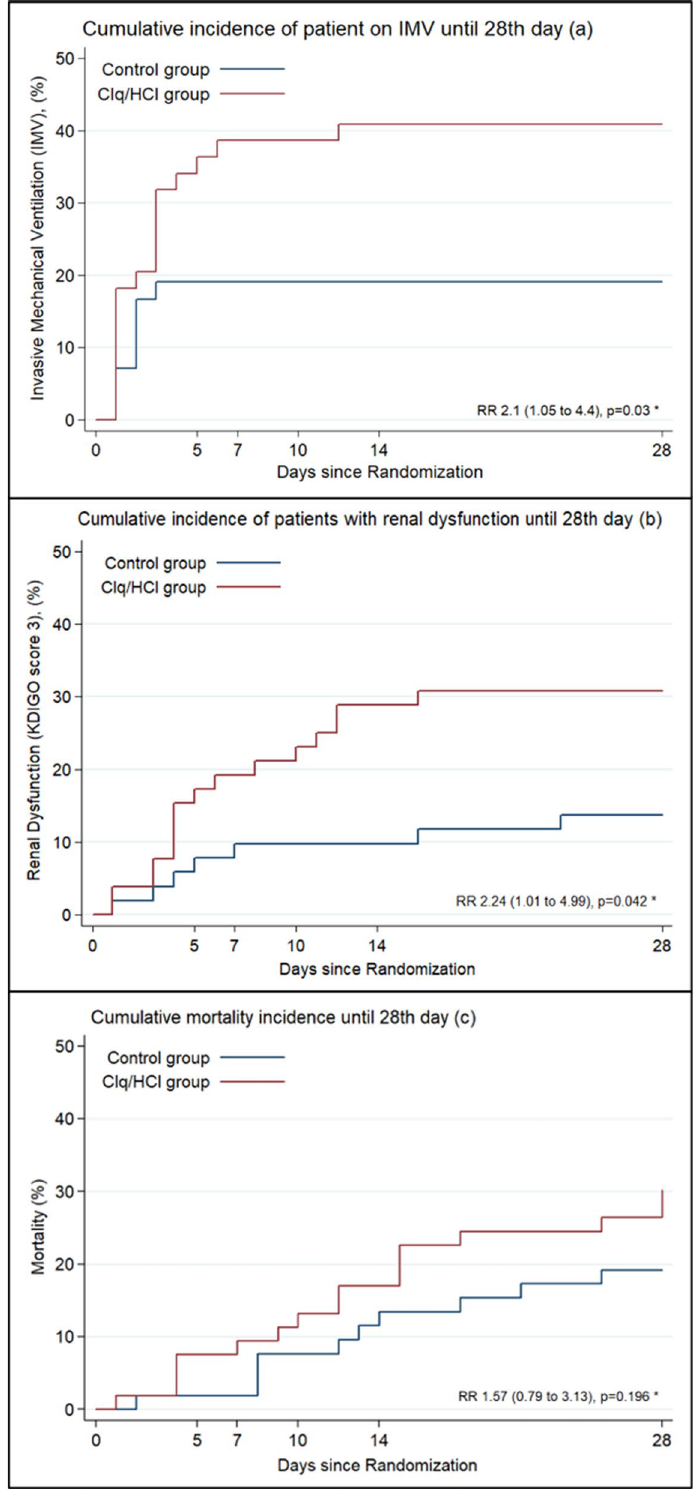
Figure 3. Cumulative incidence of IMV, acute renal dysfunction and mortality until the 28th day. (a) Considering the 44 patients from the Clq/HClq group and 42 from the control group of the mITT population who were not on MV at baseline. (b) Considering the 52 patients from the Clq/HClq group and 51 from the control group of the mITT population who were not at KDIGO stage 3 at baseline. (c) Considering the entire mITT population. *RRs with CIs calculated using the Wald likelihood